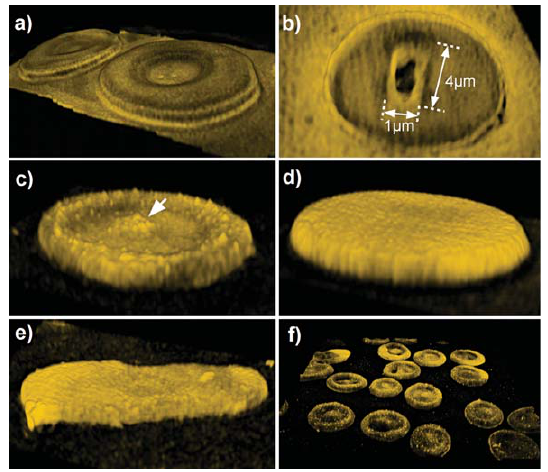
Fig.3. 3-Dmorphologicalimagesofredbloodcells.(a)Twonormal red blood cells, (b) a stomatocyte, (c) a target cell, (d) a spherocyte, and (e) an elliptocyte. (f) A collection of abnormal red blood cells, in which knizocytes are also seen. Note the central bulging part in the target cell pointed by the